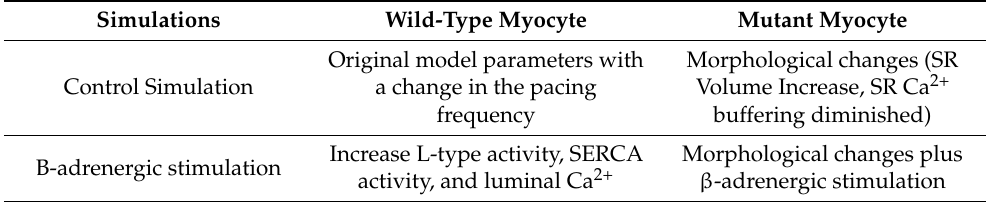
Table 2. Summary of Simulation